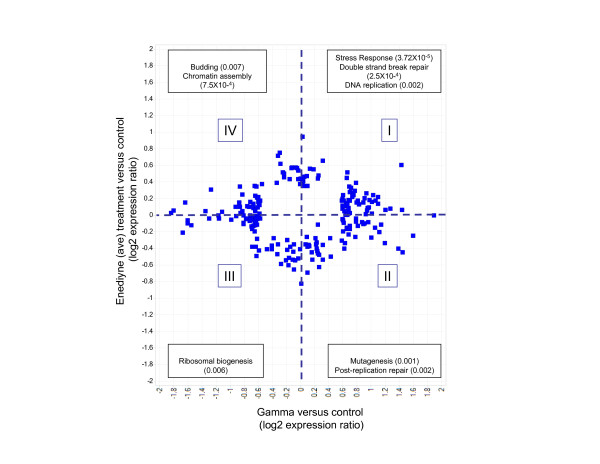
Scatter plot of relative transcriptional modulation in enediyne or γ-irradiated S. cerevisiae. The average expression ratio for enediynes was compared to that of γ-irradiated cells. Four primary sectors are identified (I-IV) demonstrating common or unique responses. Subsets of biological processes enriched (see Methods) are shown within each of the sectors [for complete list see Additional file 1].